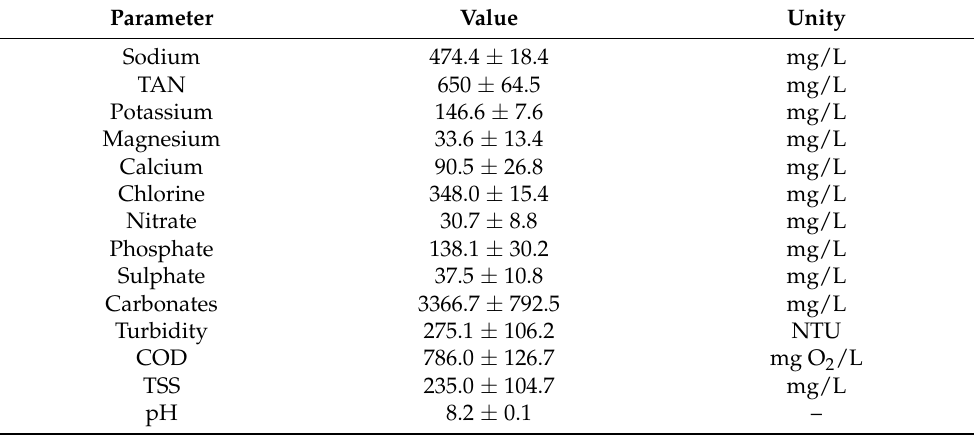
Table 4. Initial centrate